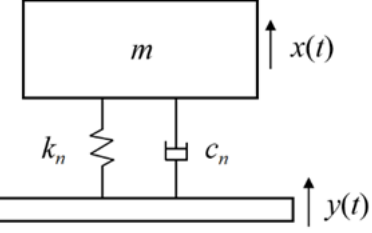
Figure 5. Schematic diagram of stiffness calibration test.